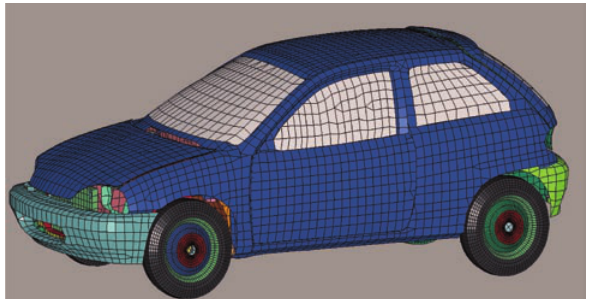
Fig. 3. General Motors GeoMetro and FEM